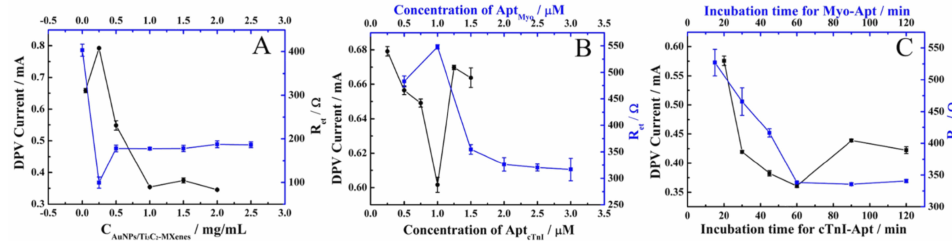
Figure 2. The optimization ( A ) and the content of AuNPs/Ti 3 C 2 -MXenes; ( B ) the concentration of Apt cTnI or Apt Myo ; ( C ) the time for cTnI or Myo